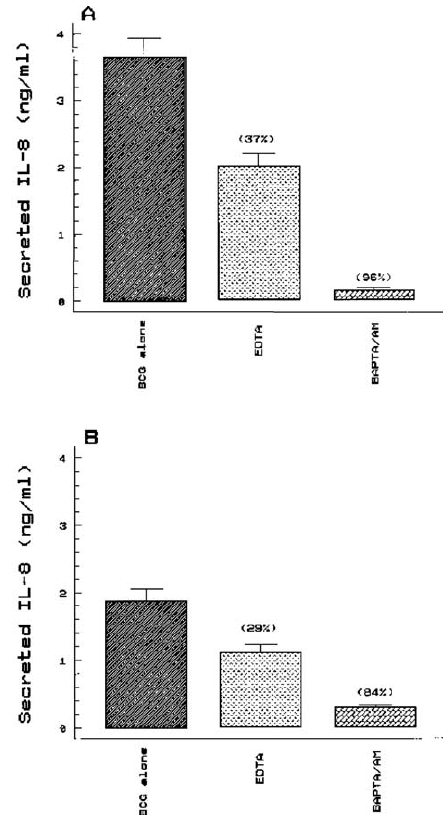
FIG. 2. Regulation of IL-8 production by calcium influx. U937 cells (A) or HEp-2 cells (B) were pretreated with 3 mM of EDTA or 30 m M of BAPTA/AM for 1 h prior to infection with M.bovisfor 48 h. IL-8 protein levels in culture supernatants were measured by ELISA. The mean and standard deviation of triplicate experiments are shown. Results in parentheses indicate the percentage of inhibition with respect to BCG